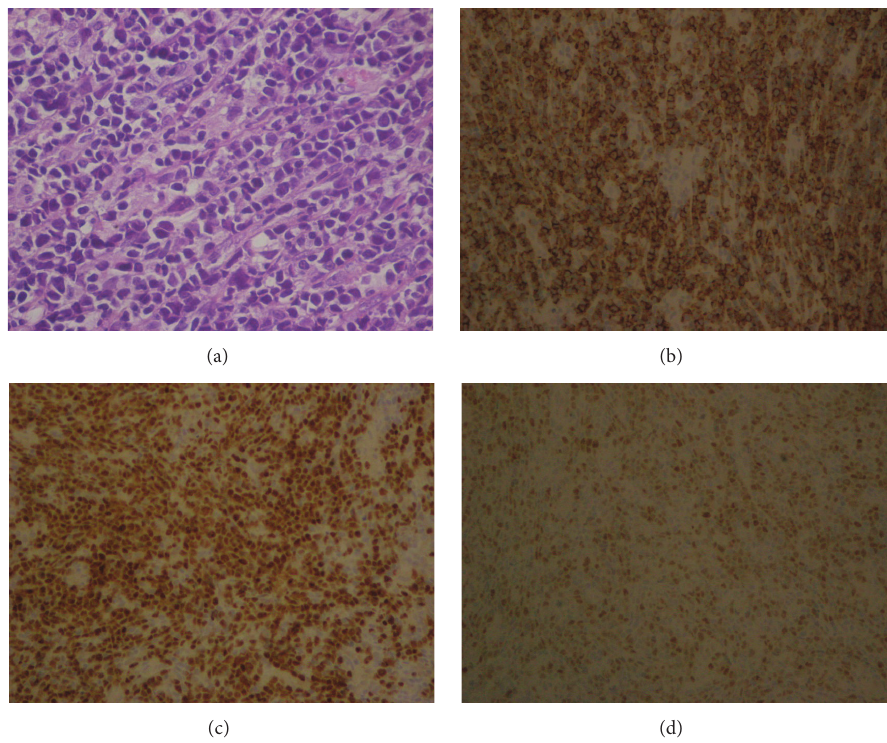
Figure 1: Histology of the nasal septal biopsy. (a) H&E High Power showing immature cells with hyperchromatic nuclei, occasional nucleoli, and high nuclear cytoplasmic ratios. (b) CD34 immunohistochemistry: positive membranous staining (CD34 marker of immature cells). (c) PAX-5 immunohistochemistry: positive nuclear staining (PAX-5 is a broad-spectrum B-lymphoid lineage marker). (d) Tdt immunohistochemistry: positive nuclear staining (Tdt marker of immature cells, favouring lymphoblastic lineage).